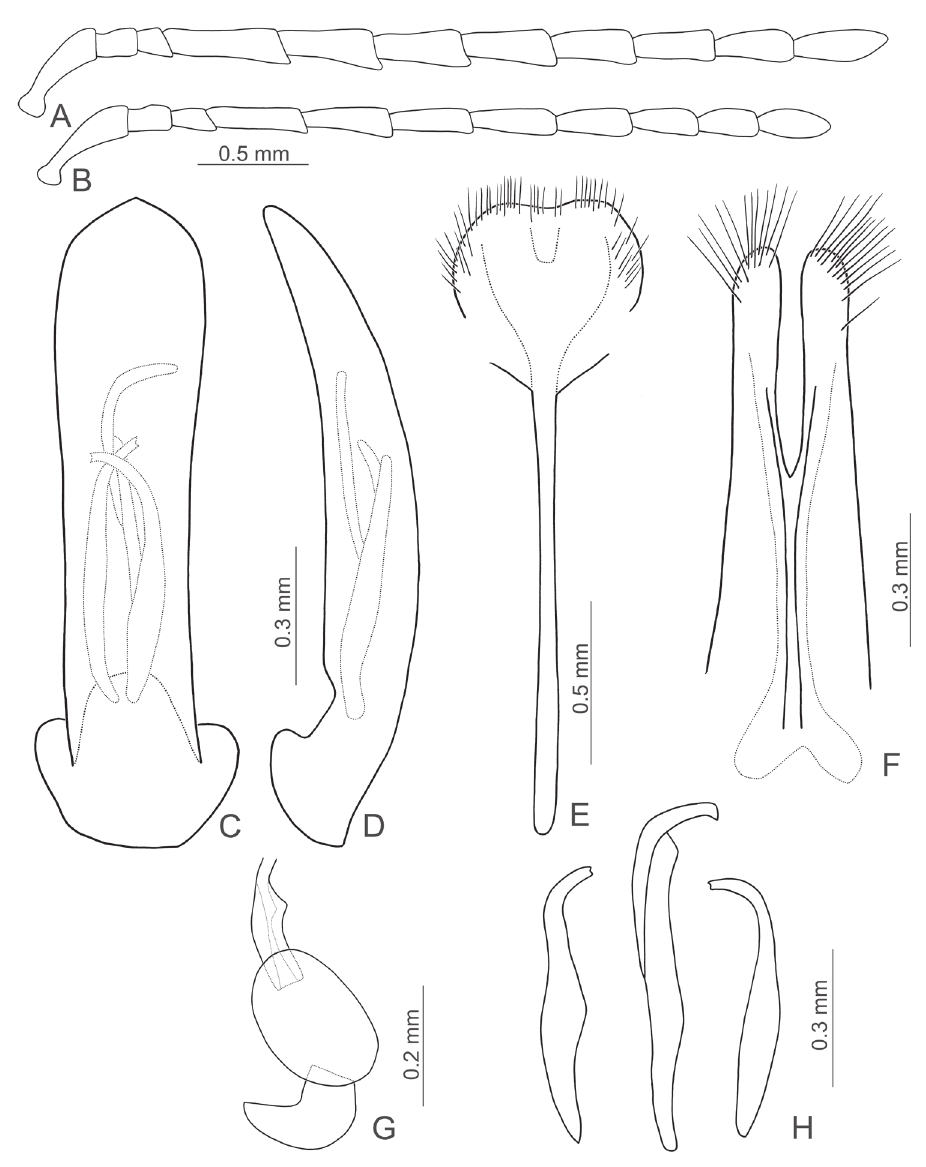
Figures 9. Diagnostic characters of Gallerucida sauteri Chûjô. A Antenna, male B Antenna, female C Penis, dorsal view D Penis, lateral view E Abdominal ventrite VIII F Gonocoxae G Spermatheca H Endophallic